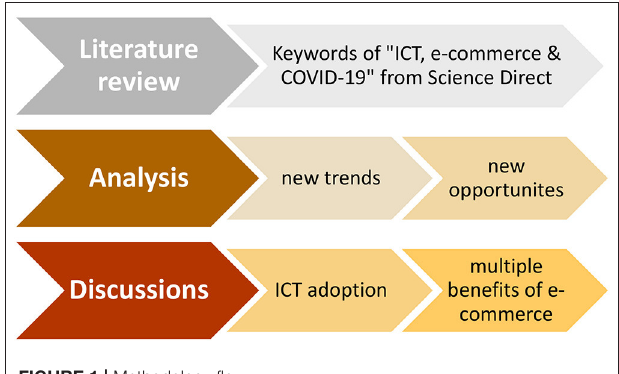
FIGURE 1 | Methodology